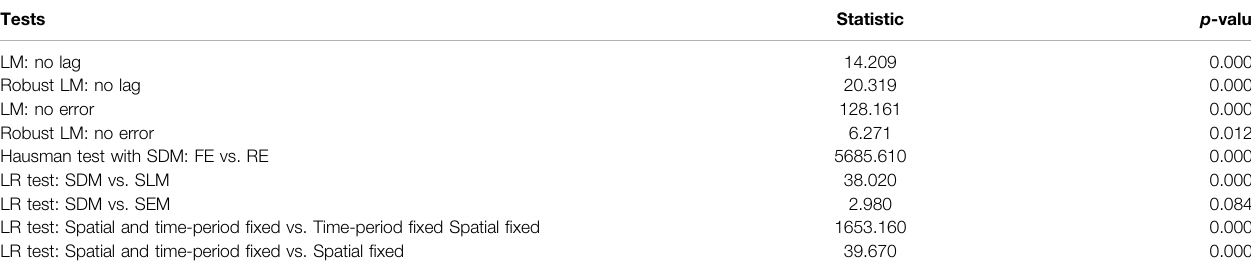
TABLE 2 | Results of the LM test, Hausman test, and LR